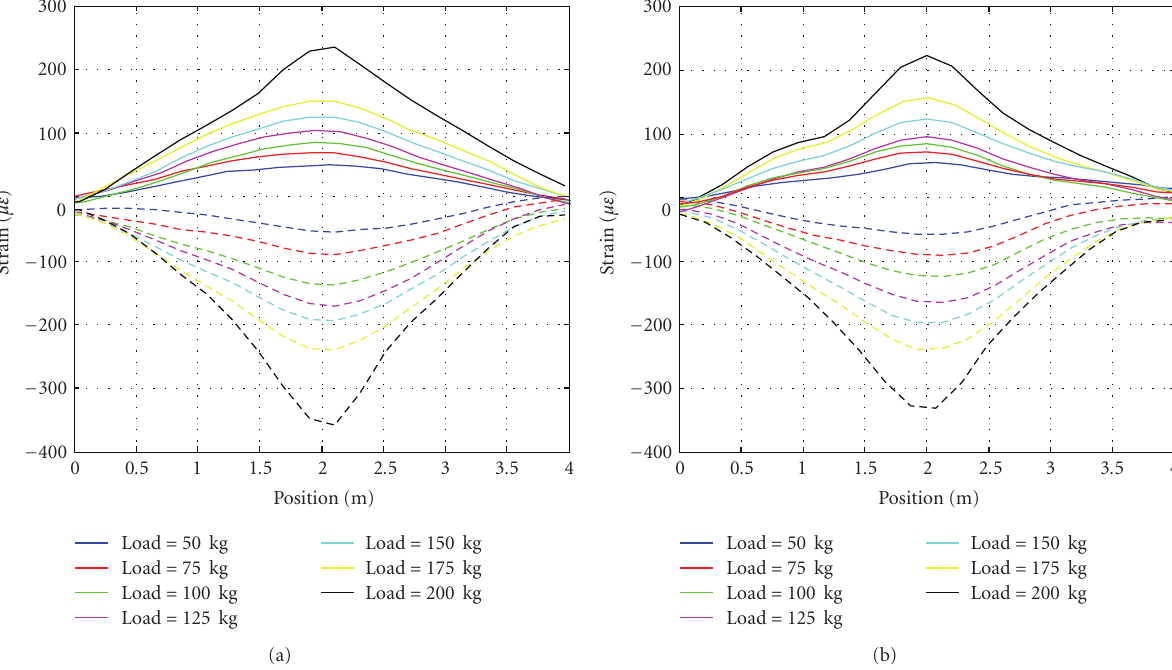
Figure 3: (a) Measured strain distribution alongthe length of the beam with fibers bonded with epoxy resin; (b) measured strain distribution along the length of the beam with fibers bonded with